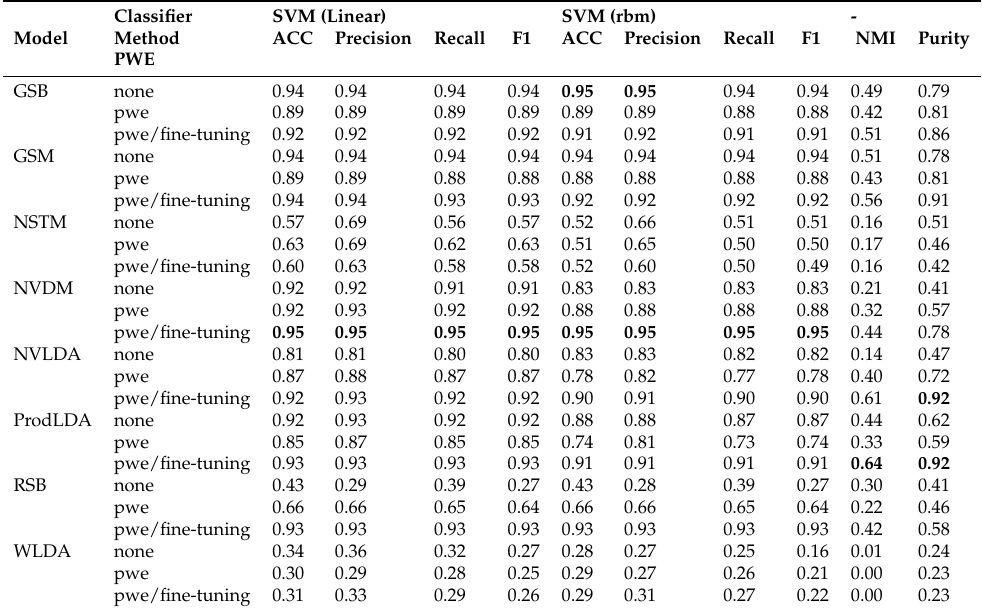
Table 24. Classification and Clustering performance on BBCNews.